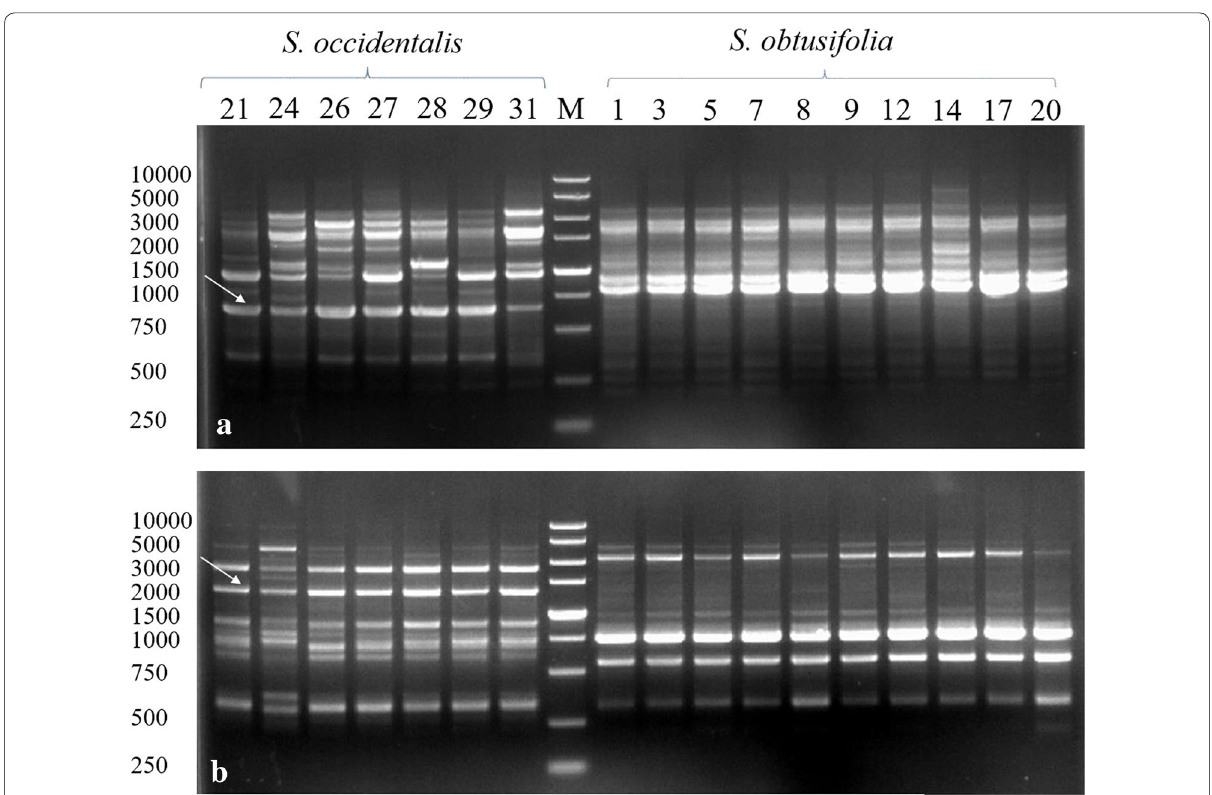
Fig. 1 The specific band (arrow indicate) generated by primers UBC80 ( a ) and SCoT 21 ( b ). The top row numbers were same with the samples number in Table 1. 7 S. occidentalis samples and 10 S. obtusifolia samples were seperated by DL5000 Marker